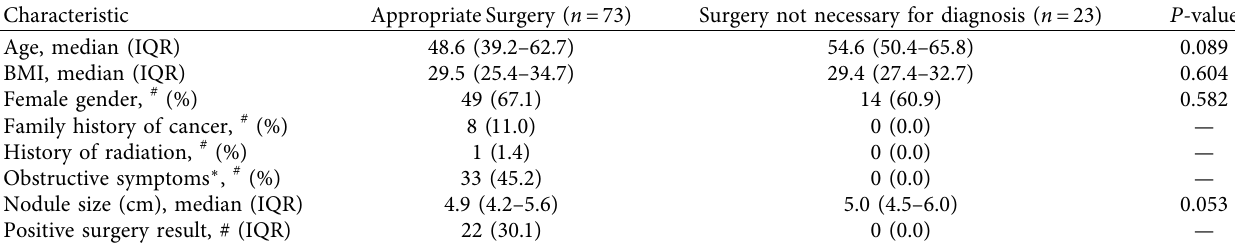
Table 4: Characteristics of patients by whether a surgery was considered appropriate for